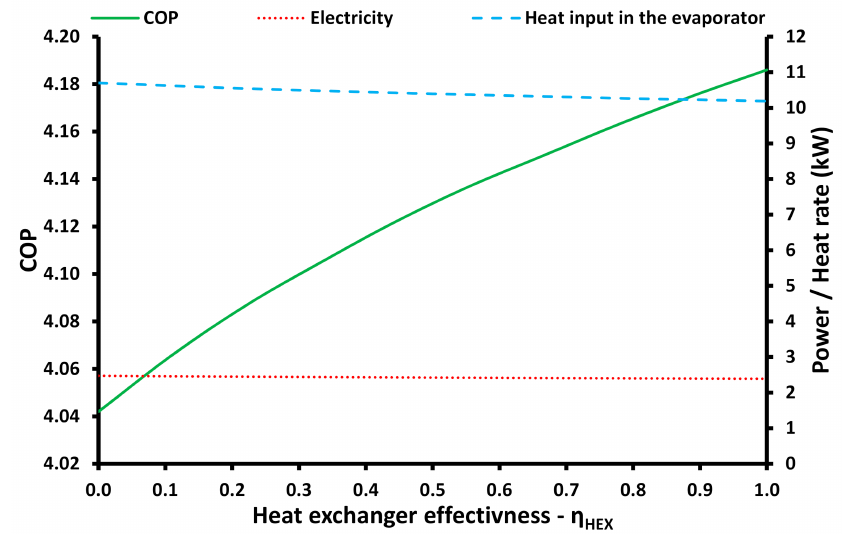
Figure 6. The impact of the heat exchanger effectiveness on the COP, electricity consumption and heat input in the